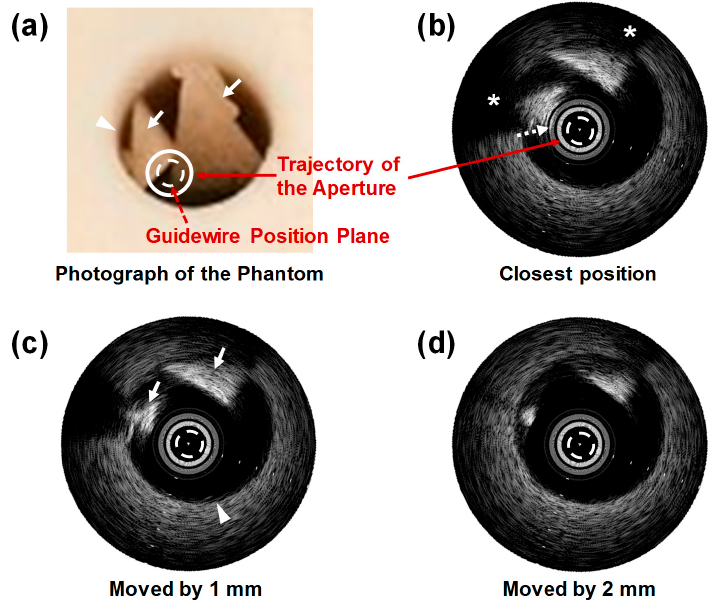
Figure 6. ( a ) Photograph of the custom blood-vessel-mimicking phantom and ( b – d ) FL–IVUS images inside the hole of the phantom (see the white solid circle in ( a )). The white solid arrows in ( a ) indicate hyperechogenic regions (i.e., the calcification-mimicking parts), and the white arrow head is the boundary between the water and the tissue-mimicking phantom. The space between the white bars on the IVUS images indicates 1 mm in the slant height. The hole in ( a ) is 8 mm in diameter.